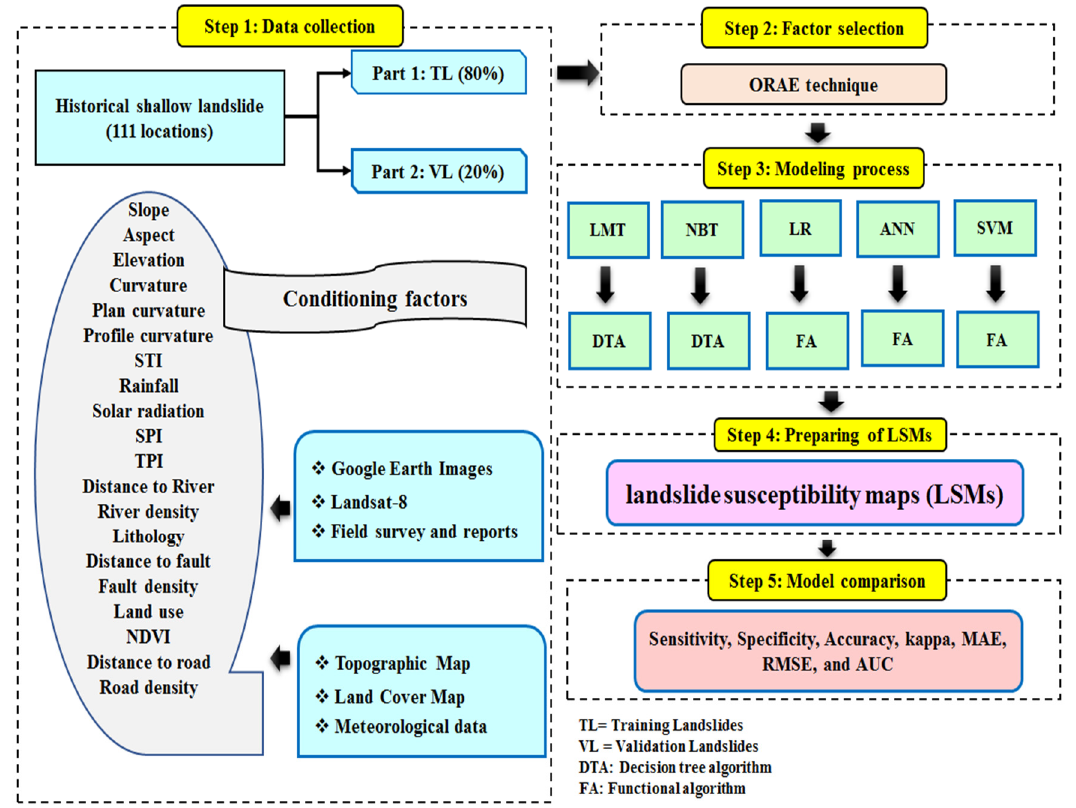
Figure 5. The flowchart of methodology used in this study.